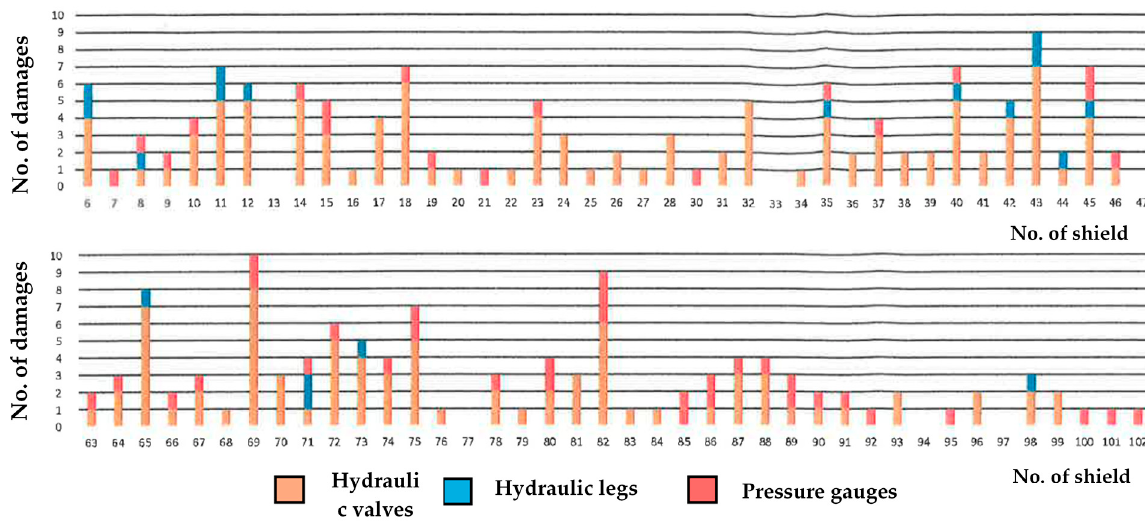
Figure 2. Monitoring of damage events of the powered roof support in the longwall (DOH Hydraulics Center) during the mining process.